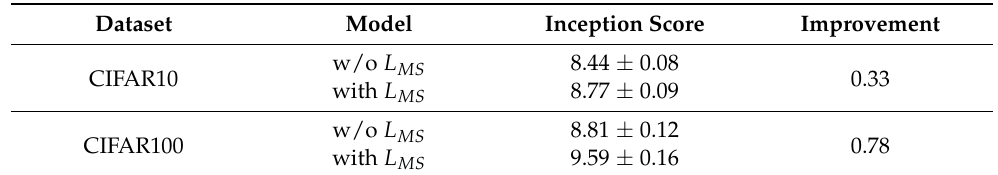
Table 1. The Inception scores for HRGAN-32 with and without the backpropagation of the proposed score.